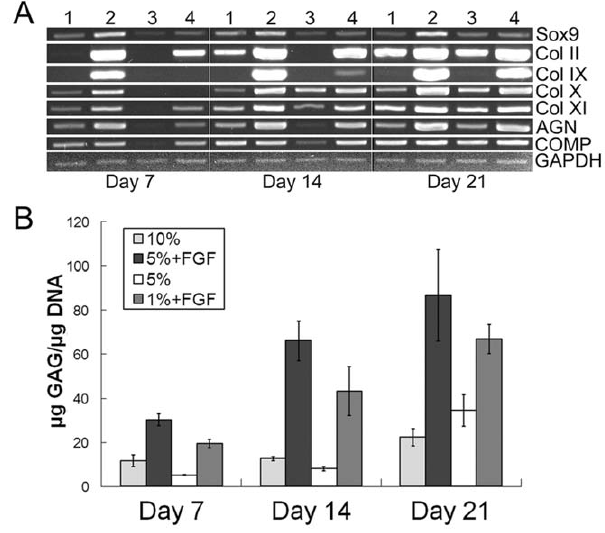
Figure 1. FGF-2 enhances hMSC CG. Human MSCs were expanded in varying concentrations of FBS with or without FGF-2 for 2 passages prior to CG and analyzed for cartilaginous properties upon differenti- ation in pellet culture. (A) End-point RT-PCR analysis showed that cartilage-specific gene expression was upregulated in the 2 FGF-2- expanded conditions (Lanes 2 and 4) at each time point compared to those without FGF-2 pretreatment (Lanes 1 and 3). Lane 1: 10% FBS; Lane 2: 5% FBS + FGF-2; Lane 3: 5% FBS; Lane 4: 1% FBS + FGF-2. (B) Significantly greater GAG accumulation was observed in the 2 FGF-2- expanded conditions at each time point compared to those without FGF-2 pretreatment. GAG content was normalized to DNA content. Values are mean 6 SD. All conditions were significant with each other except the 2 FGF-2-expanded conditions at Day 21. p , 0.05, n=3.